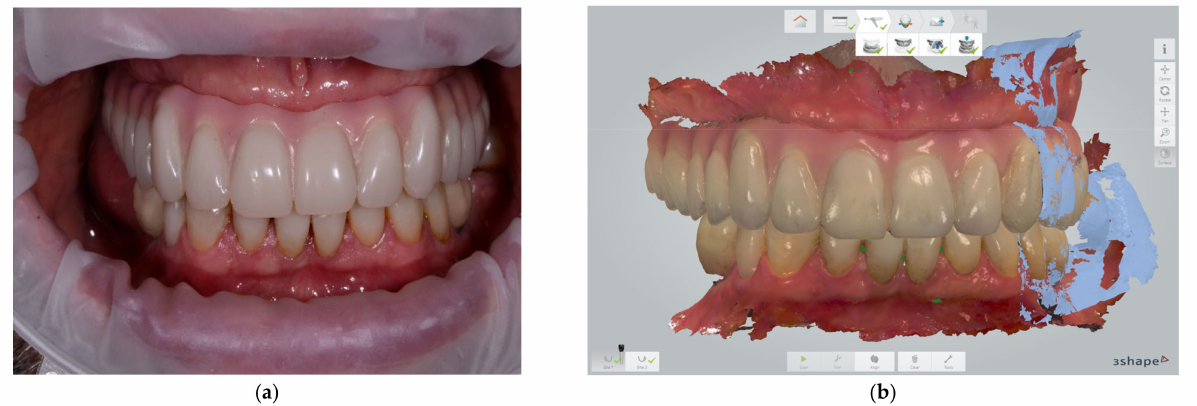
Figure 2. ( a ) Intraoral clinical view 4 months after installation of the maxillary full-arch fixed implant prosthesis on multi-unit abutment level. ( b ) The maxillary scan with the full-arch fixed implant prosthesis was saved in pre-preparation mode (3Shape Dental Desktop 1.7.9.1, 3Shape, Copenhagen, Denmark).